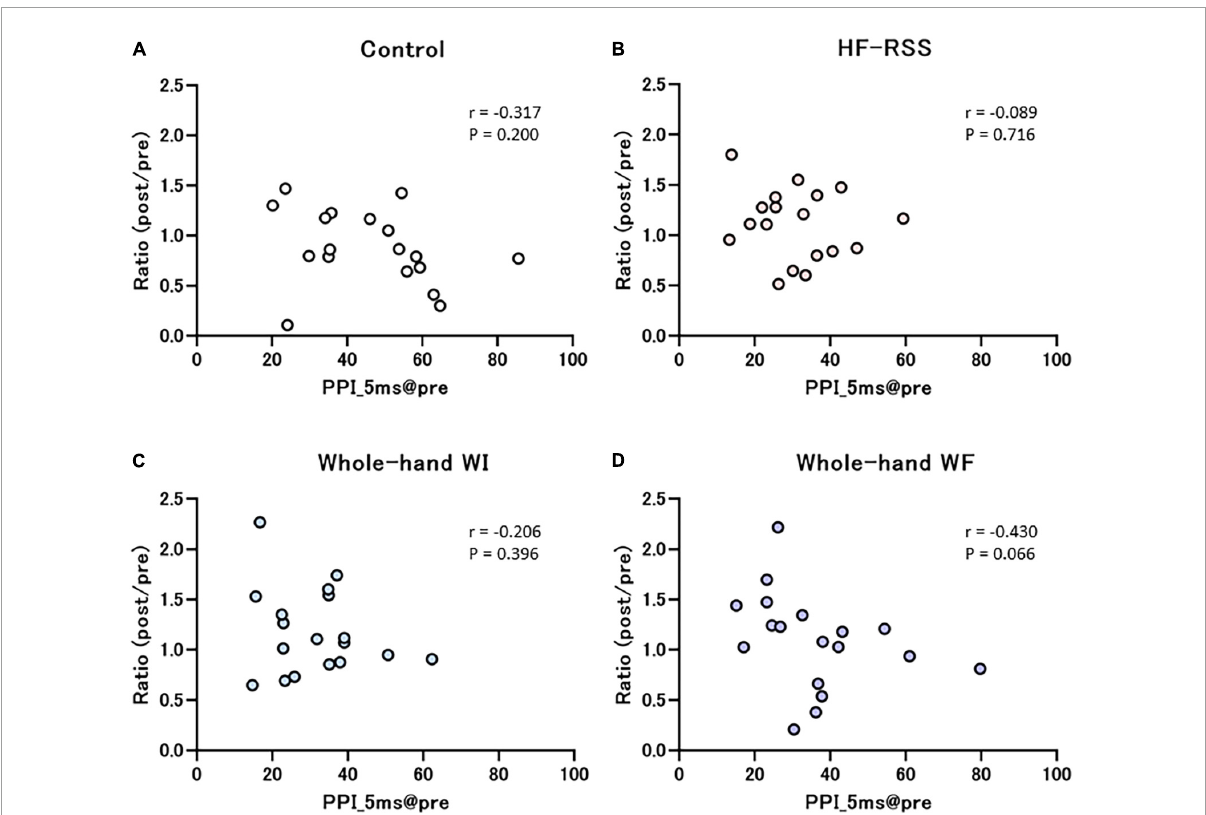
FIGURE7 Correlation between PPI_5 ms at pre-intervention and the ratio of before to after each intervention: (A) Control, (B) HF-RSS, (C) Whole-hand WI, and (D) Whole-hand WF. There was no significant correlation in any intervention. HF-RSS, high-frequency repetitive somatosensory